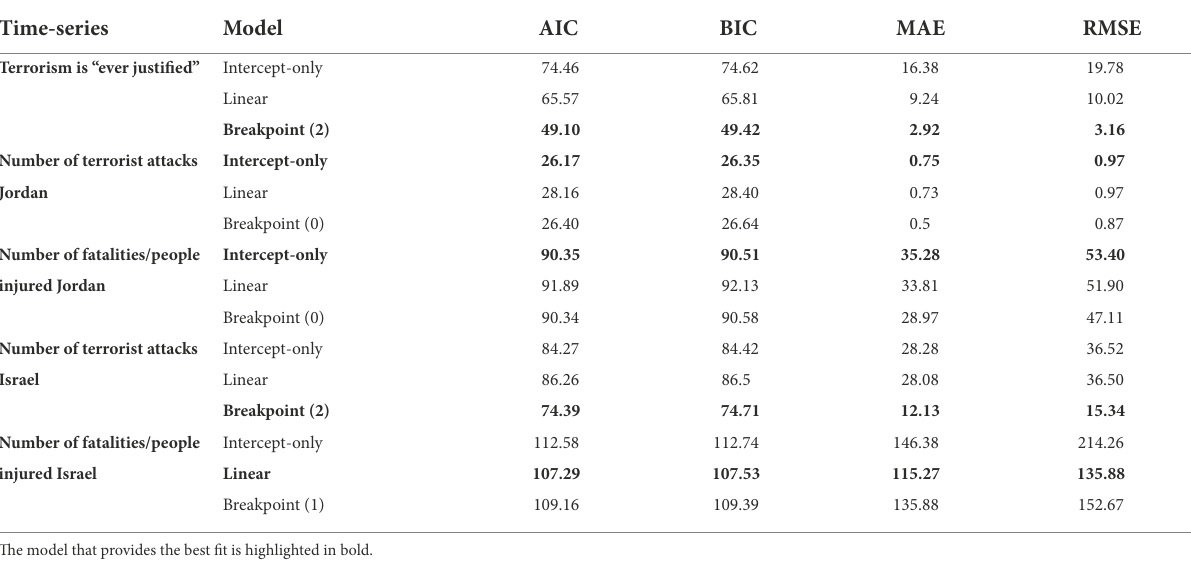
TABLE 5 Model fit for all time-series.